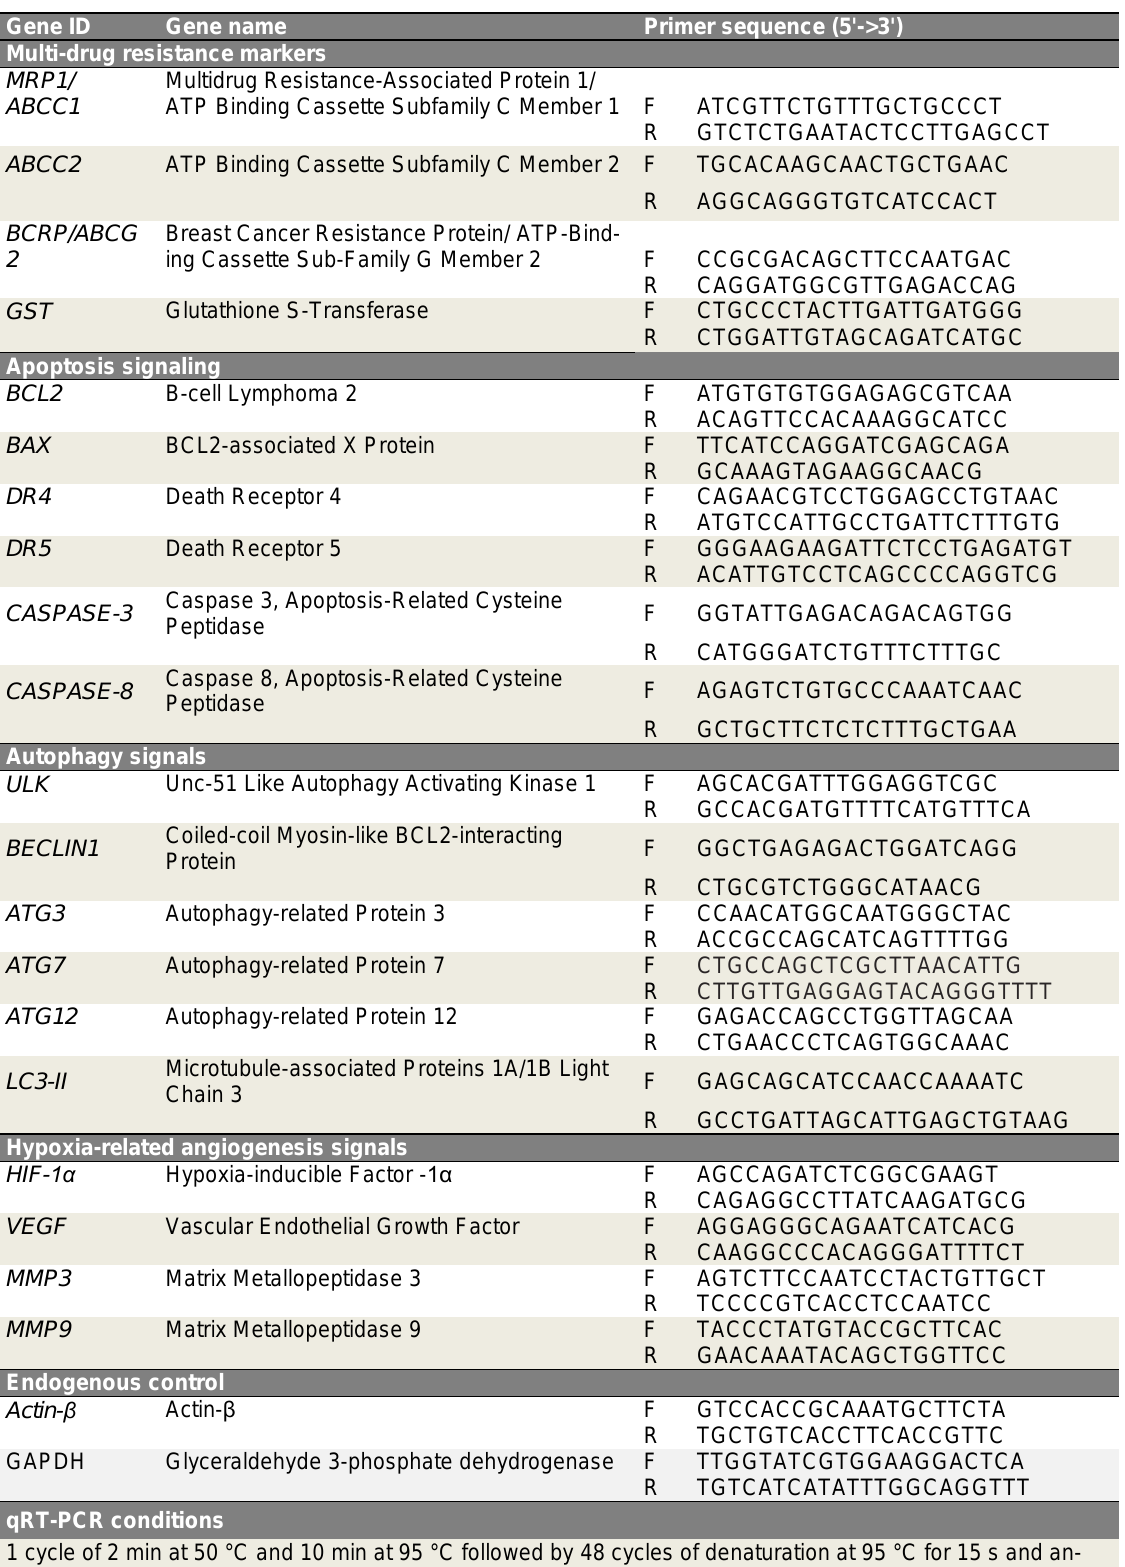
Table 2: Genes, primer sequences, and PCR conditions used in qRT-PCR